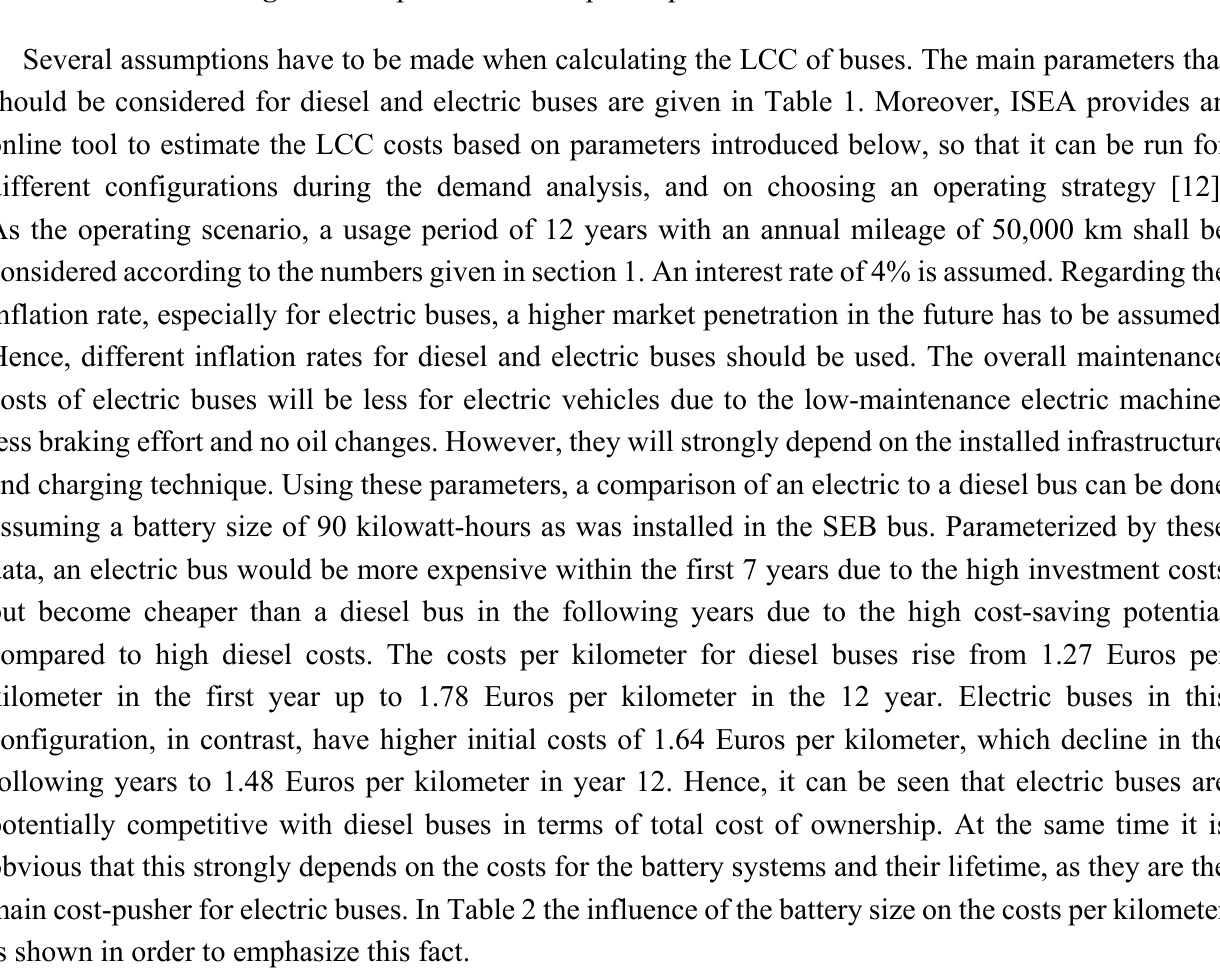
Figure 1. Steps in the development process of an electric